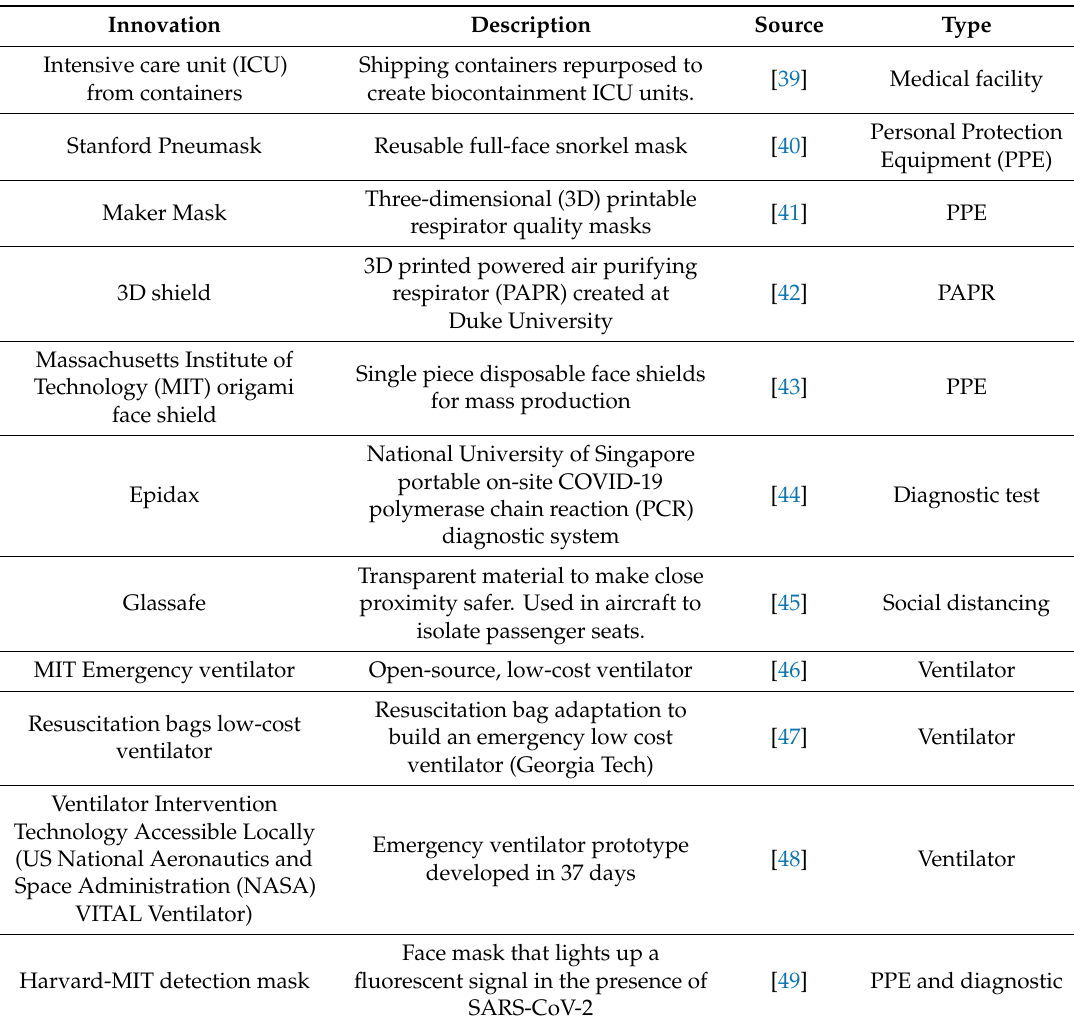
Table 1. Contemporary innovations in the field of biomedical devices to tackle the current COVID-19 pandemic, as well as future